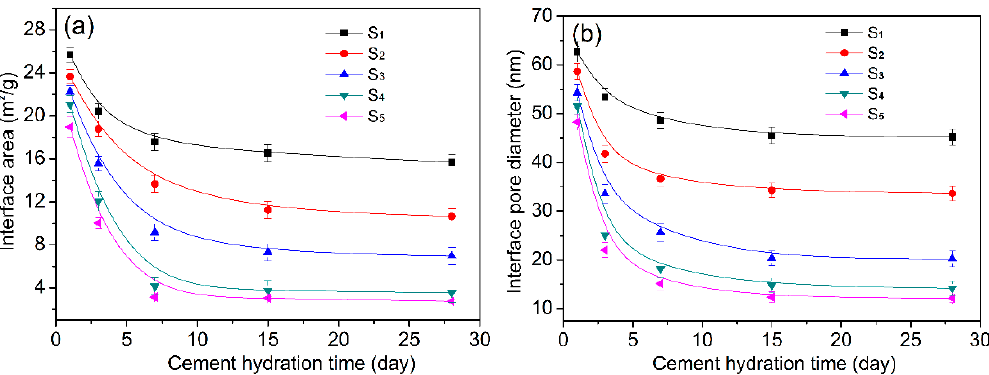
Figure 12. Interfacial areas ( a ) and pore diameters ( b ) within cement composites. Table 2. Interfacial areas within cement composites. Interfacial Areas (m 2 /g)